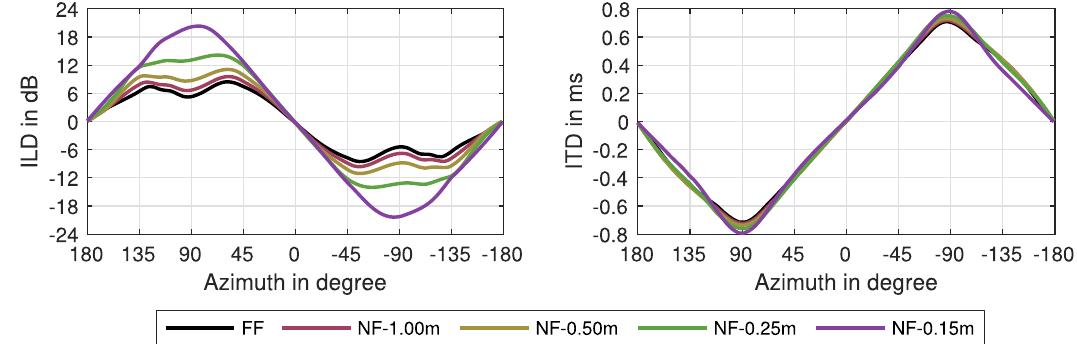
Figure 1. Low-frequency ( f < 3 kHz) horizontal plane ILDs (left) and ITDs (right) of the intensity-scaled far- fi eld HRTF sets (FF) and synthesized near- fi eld HRTF sets (NF) at selected distances.